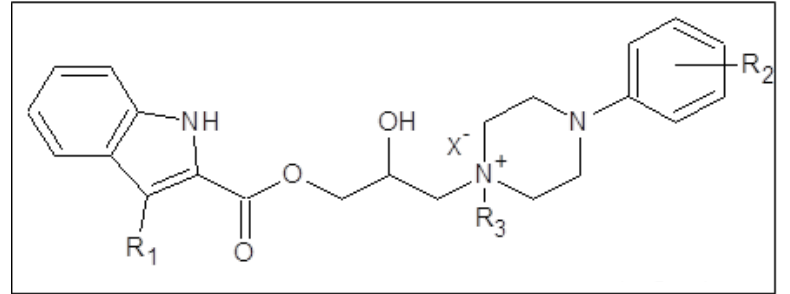
Figure 1. The common structure of synthesized compounds.